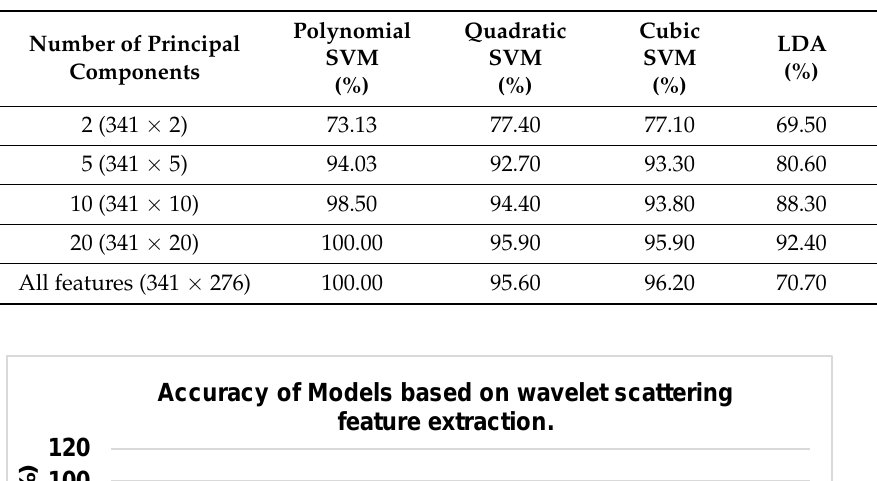
Table 4. Evaluation of number of principal components and model accuracies.